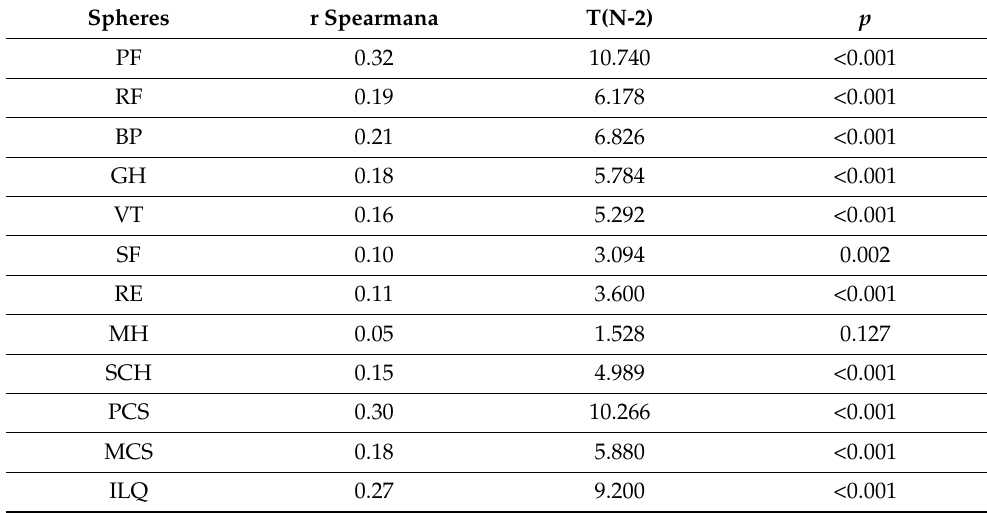
Table 5. Spearman rank-order correlation in SF-36 by age group. Spheres r Spearmana T(N-2) p PF 0.32 10.740 <0.001 RF 0.19